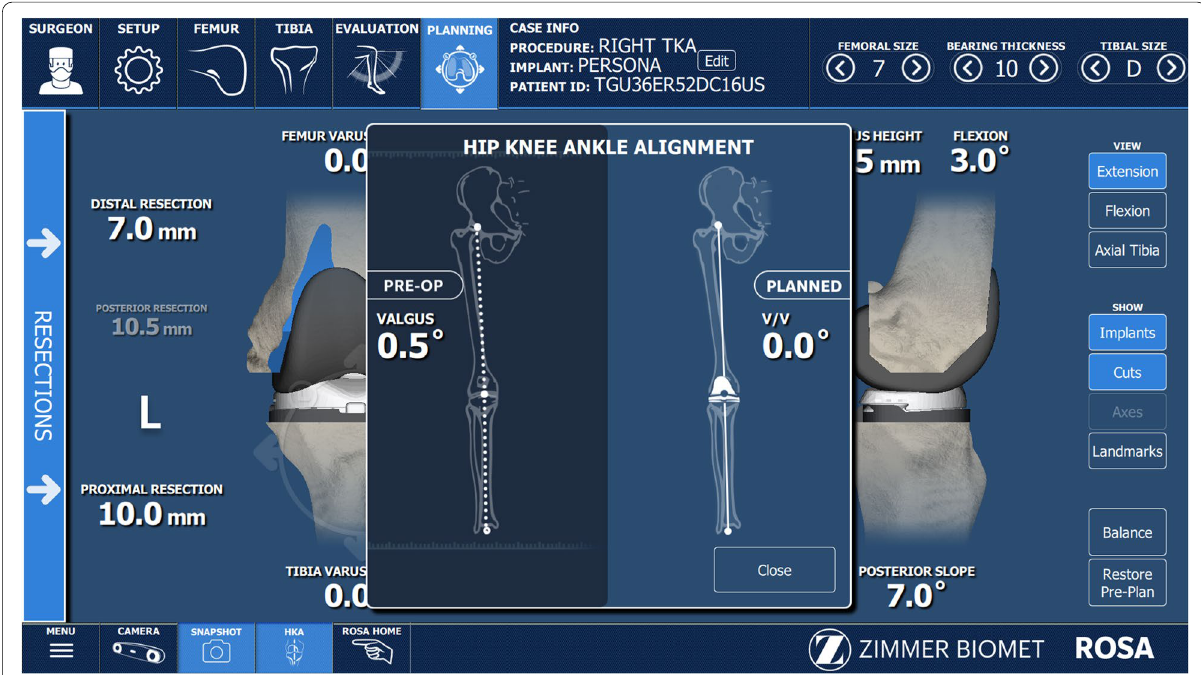
Fig. 4 An intraoperative image demonstrating the alignment assessment by the robotic system